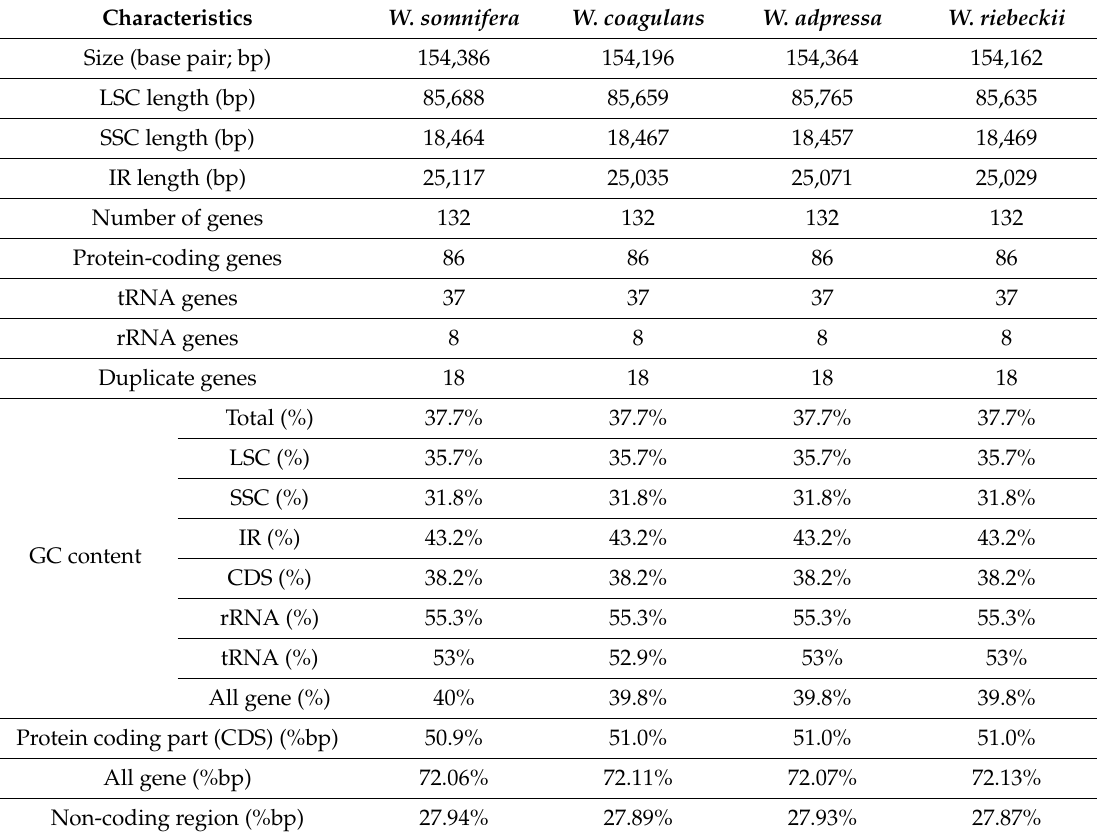
Figure 2. Consensus circular genome map of Withania plastomes . The first larger ring represents the gene structure of the chloroplast genome. The GC content is plotted as a green line while a skewed GC plot is presented as an orange/black track around the inner circles. The second ring is displaying the IRs as longer black boxes, while tandem repeats are represented by short bars. The third, and last circle shows the output of MISA microsatellite detection, where reverse repeats are connected with green arcs, while red arcs represent forward repeats.